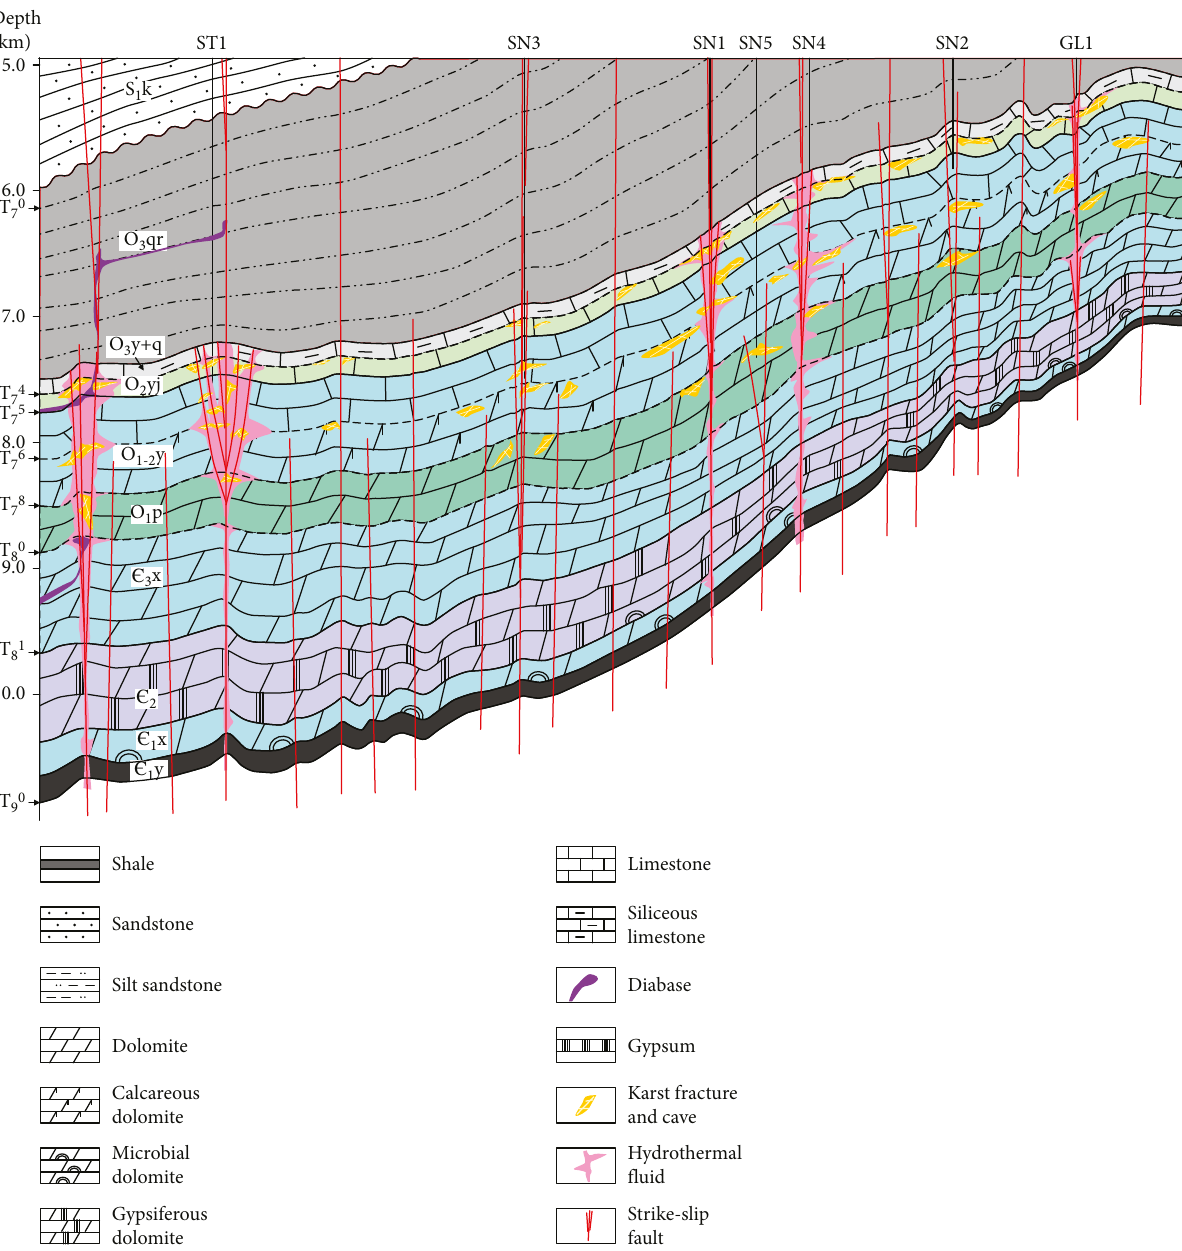
Figure 10: Crossing well pro fi le of the deep Ordovician carbonate reservoir in fl uenced by the fault-hydrothermal alteration in the Shunnan area, Tarim